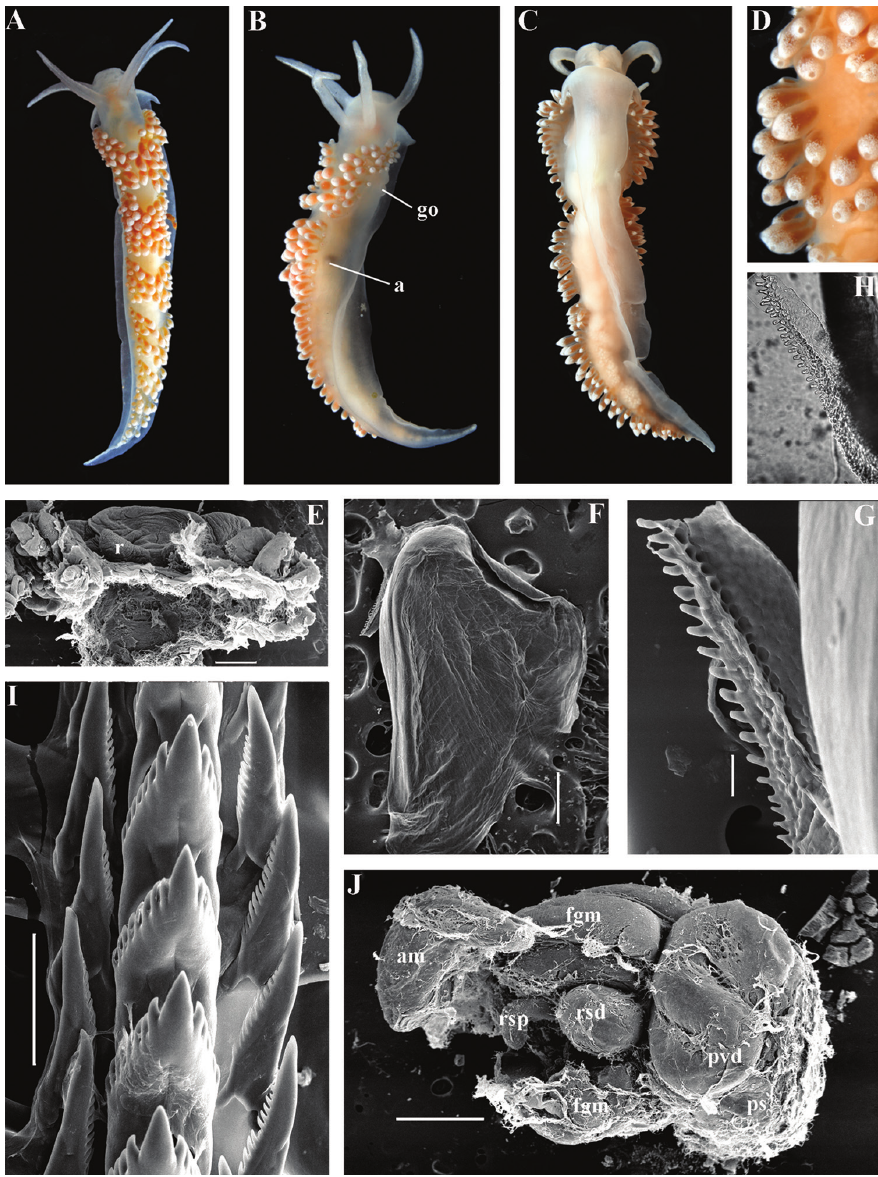
Figure 19. Coryphella verrucosa (M. Sars, 1829), short cerata (typical) morphotype. ZMMU Op-539. Norwegian Sea, Gulen Dive Center, living specimen 38 mm in length: A dorsal view B lateral view C right ventral view D details of cerata E dissected anterior part (pharynx removed) and rhinophores, SEM F jaw, SEM G details of masticatory process of jaw, SEM H details of masticatory process of jaw, light microscopy I radular teeth, posterior part, SEM J reproductive system, SEM. Abbreviations: a anus am ampulla rsd distal receptaculum seminis fgm female gland mass go genital opening ps penial sheath pvd prostatic vas deferens r rhinophores rsp proximal receptaculum seminis. Scale bars: E, J = 1 mm; F = 300 μm; G = 30 μm I = 100 μm. Photos and SEM images by T.A. Korshunova, A.V.